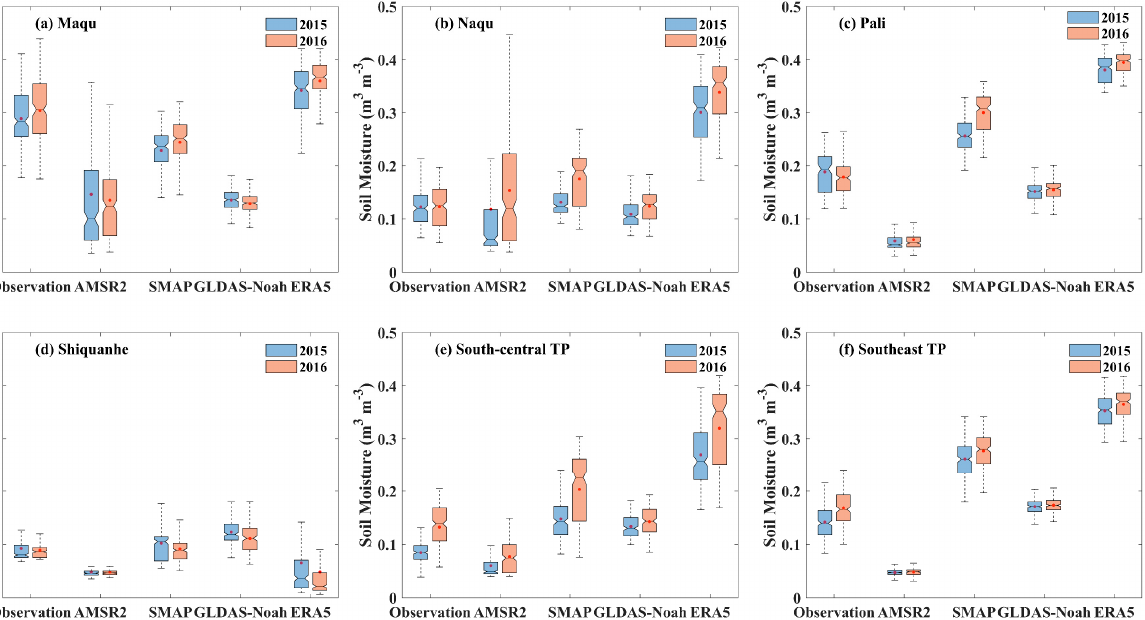
Figure 2. The time series for SM of in situ observations, AMSR2, SMAP, GLDAS-Noah, ERA5, and the in situ observed rainfall in April–October from 2015 to 2016 in different TP regions.